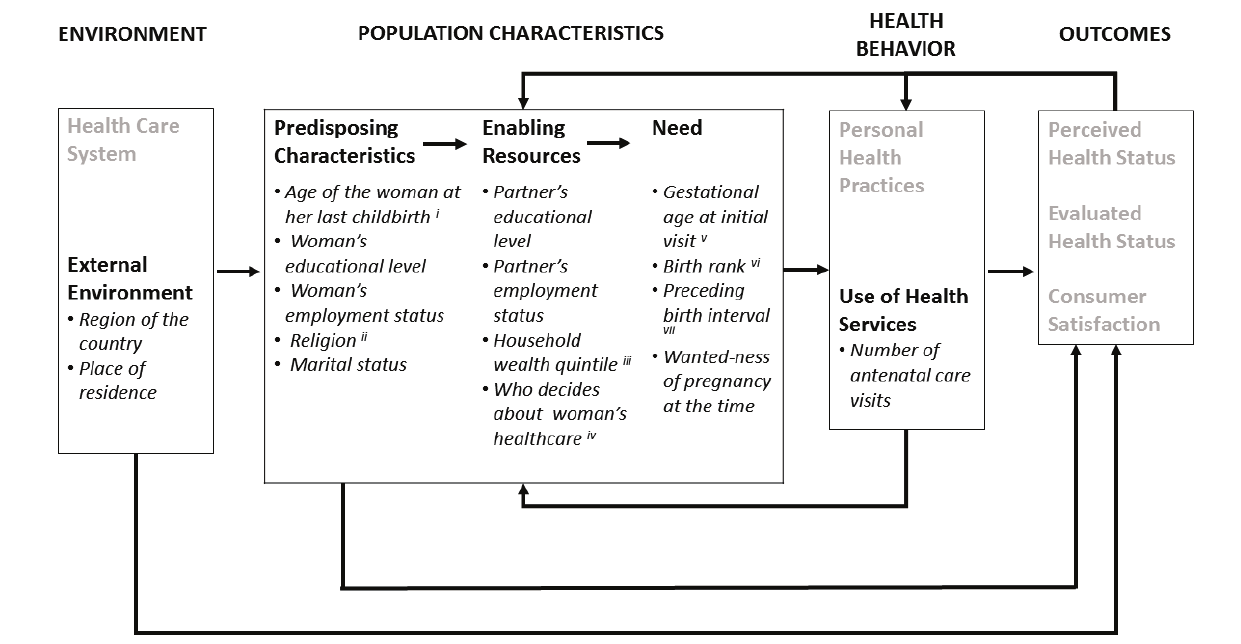
Figure 1. The conceptual framework based on Anderson’s Behavioral Model of Healthcare Use and the corresponding determinants used in our secondary analysis [ 31 ]. Source: Anderson 1995 [ 31 ]. i Age at woman’s most recent birth was calculated by subtracting the last child’s date of birth from the woman’s date of birth divided by 12. ii Religion was categorized as dominant religion and other religions. iii Household wealth quintile is made up of five wealth quintiles from poorest to richest as constructed by DHS where each quintile represents 20% of the households in the study sample. iv The variable ‘who decides about woman’s health care’ is categorized as: woman alone, woman & partner, partner alone, someone else. v Gestational age at first ANC visit was grouped into trimesters.